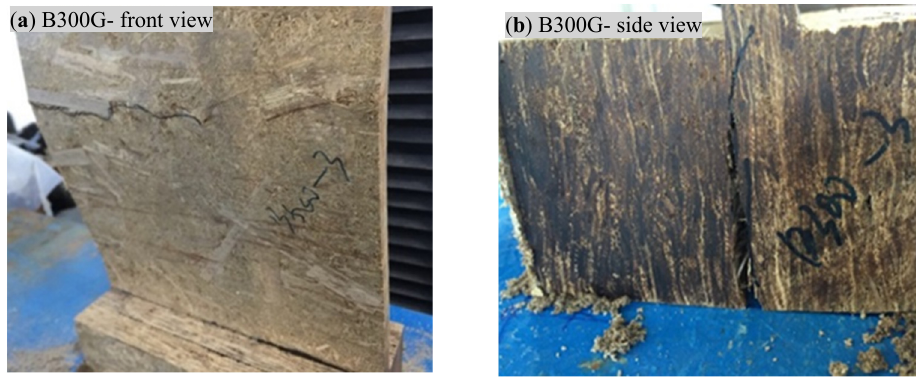
Figure 5. Uniform vertical load test failure of B300G.